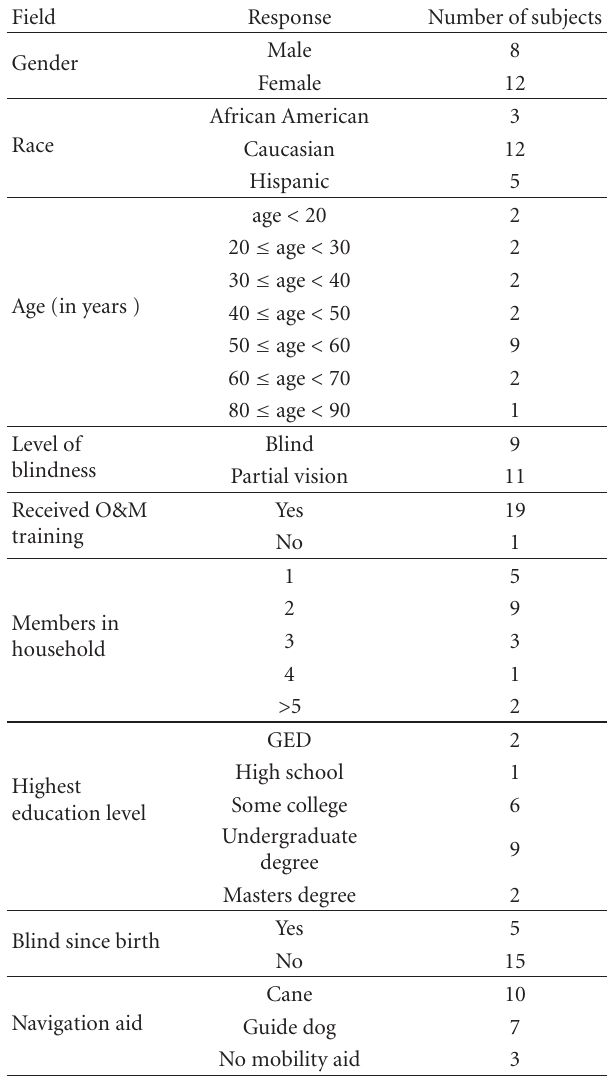
Table 2: Population for Phase II